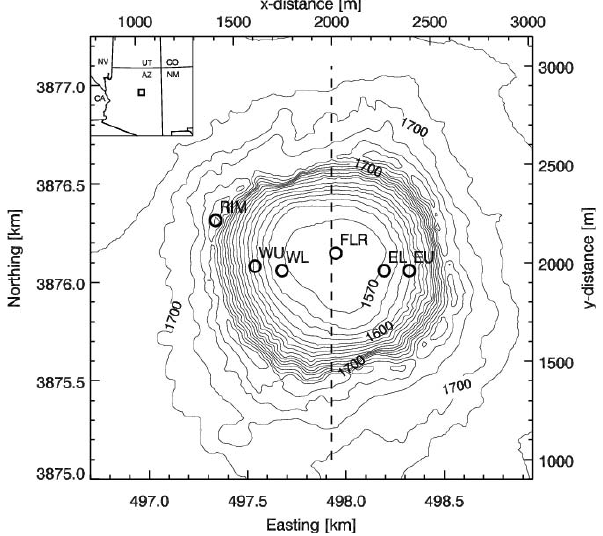
Fig. 4. Topographic map showing the radiation measurement sites within the crater. The dashed line shows the location of the transect discussed